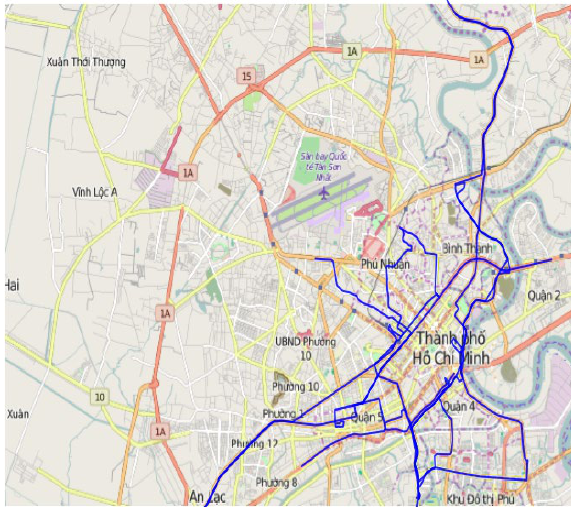
Fig.9. Clustering results obtained from Ho Chi Minh City Dataset: difference between transit buses and long-distance